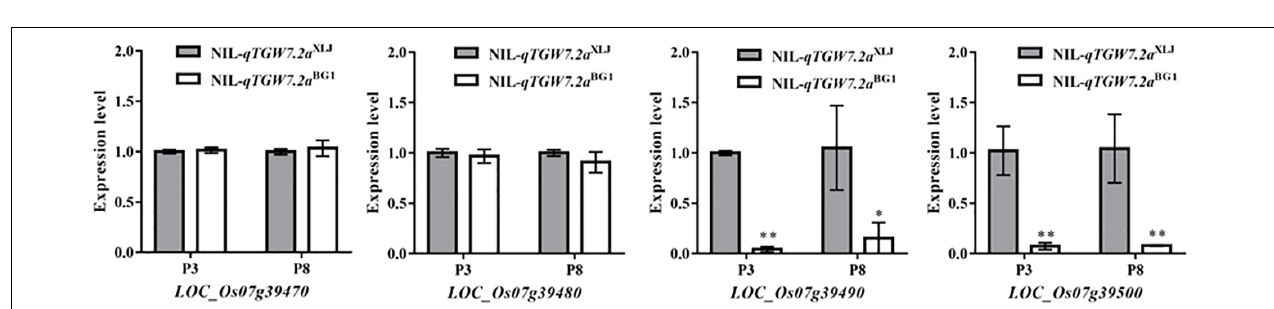
FIGURE 4 | The transcript levels of annotated genes between NIL- qTGW7.2a XLJ and NIL- qTGW7.2a BG 1 . The experiment was performed using panicles of 1 ≤ P < 3 cm (P3) and 5 ≤ P < 8 cm (P8) collected from NIL- qTGW7.2a XLJ and NIL- qTGW7.2a BG 1 . Data are given as mean ± SD. Student’s t -test was used to generate P value; ∗ P < 0.05; ∗∗ P <